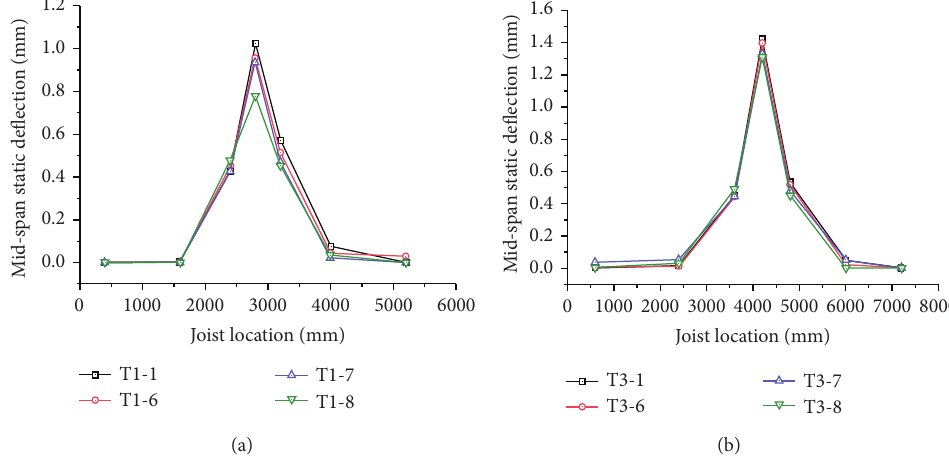
Figure 10: Midspan static deflections of the test floors with the joist spacings of 400mm and 600mm before and after installation of strappings under the concentrated load of 1kN at the floor